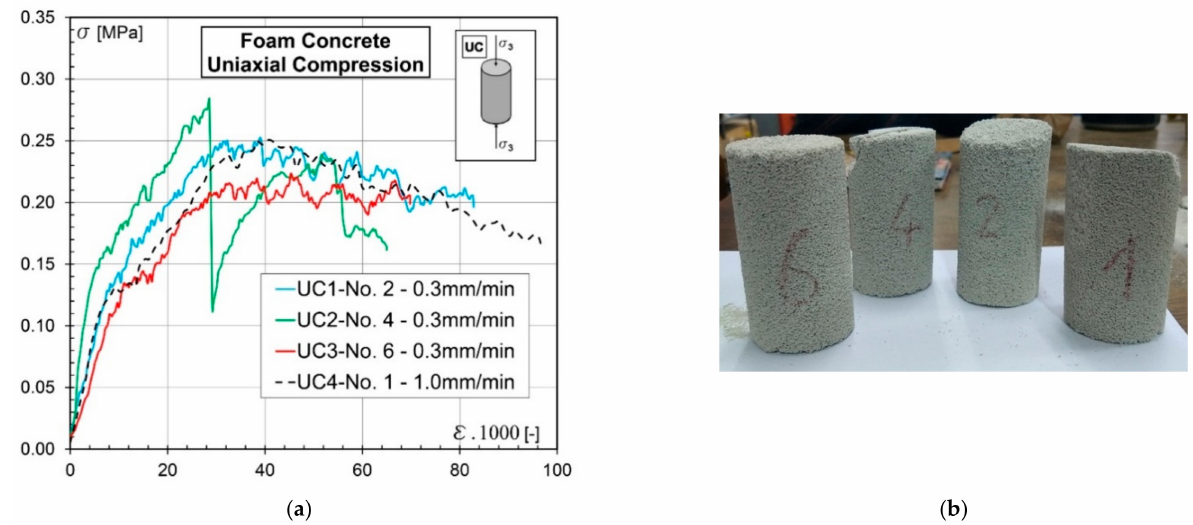
Figure 8. Uniaxial Compression tests: ( a ) stress–strain curves and ( b ) images of failure modes.